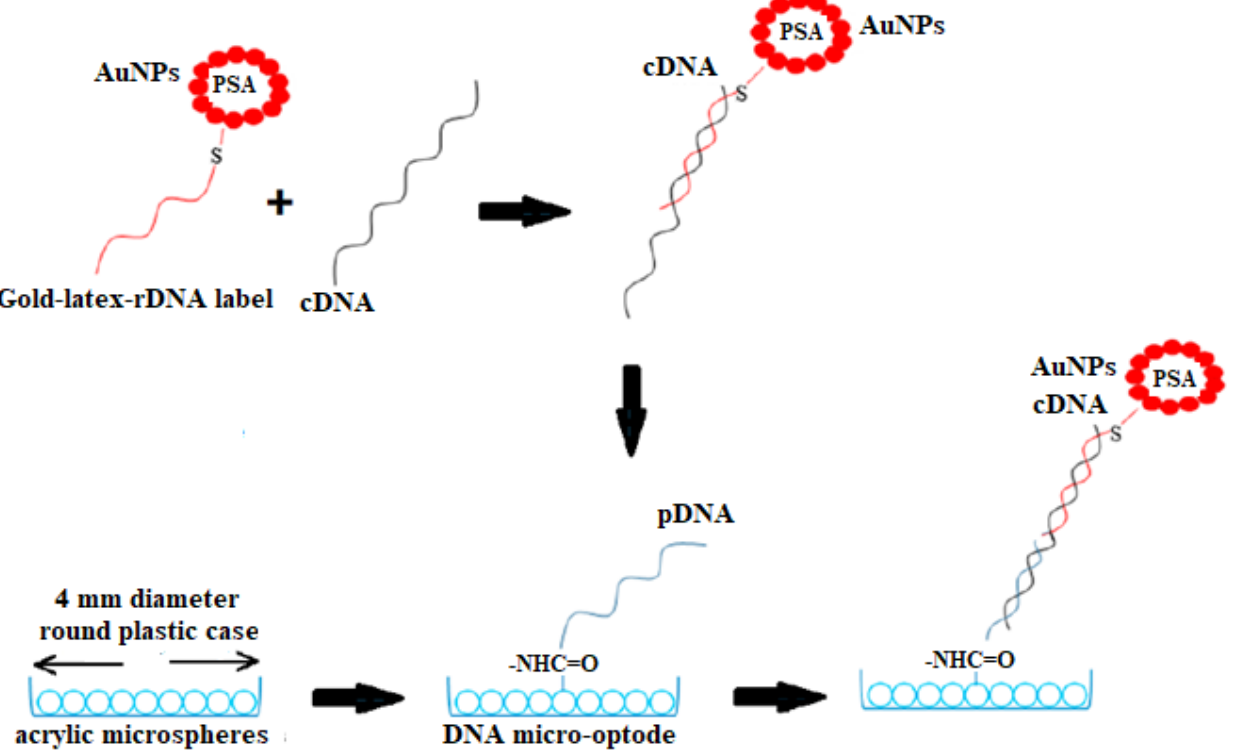
Figure 7. Schematic diagram showing the one-step sandwich hybridization recognition procedure, which involves a DNA capture probe (pDNA) immobilized on the acrylic microspheres, and target (cDNA) and reporter (rDNA) probes labeled with gold nanoparticle–poly(styrene- co -acrylic acid) latex (AuNP–PSA) spheres. Reproduced from Jeningsih et al. [104].